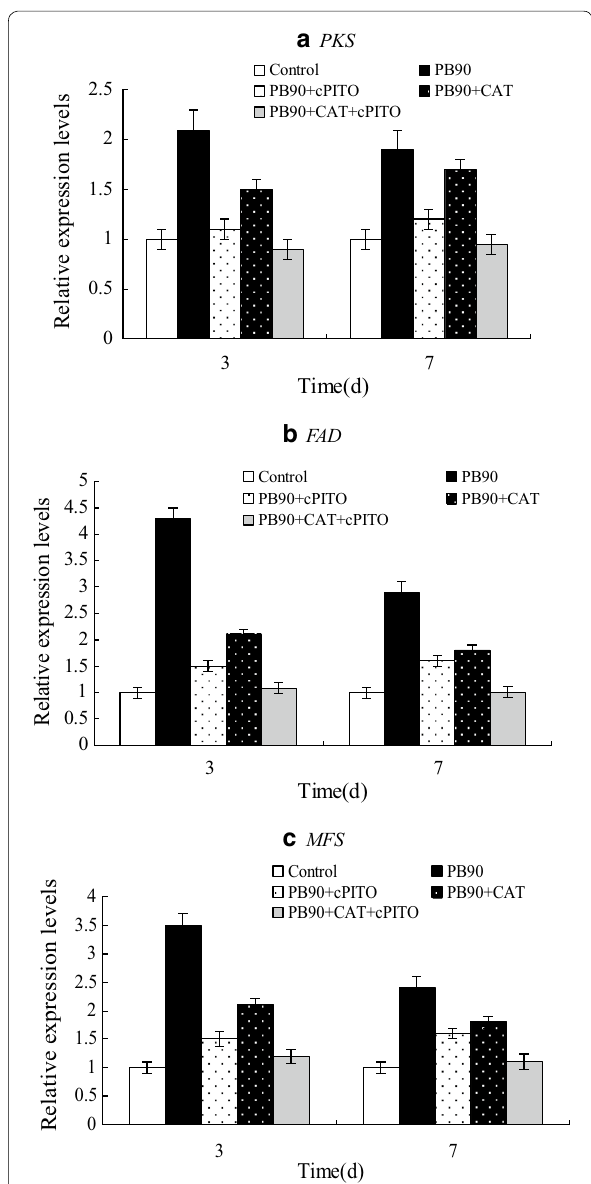
Fig. 6 Effects of PB90 on some genes expression of S . bambusicola . PKS : polyketide synthase ( a ), FAD : FAD/FMN-dependent oxidoreductase ( b ), MFS : major facilitator superfamily ( c ). Three-day-old cells treated with 5 nmol/L PB90, hypocrellin production were measured at 3 days after PB90 was added. 0.5 mmol/L cPITO and 0.5 mmol/L CAT were added to 3-day-old cells respectively. The adding time of cPITO and CAT was 30 min before PB90 treatment. The control received vehicle solvent only. The results shown are the average of five independent experiments. Bars represented standard